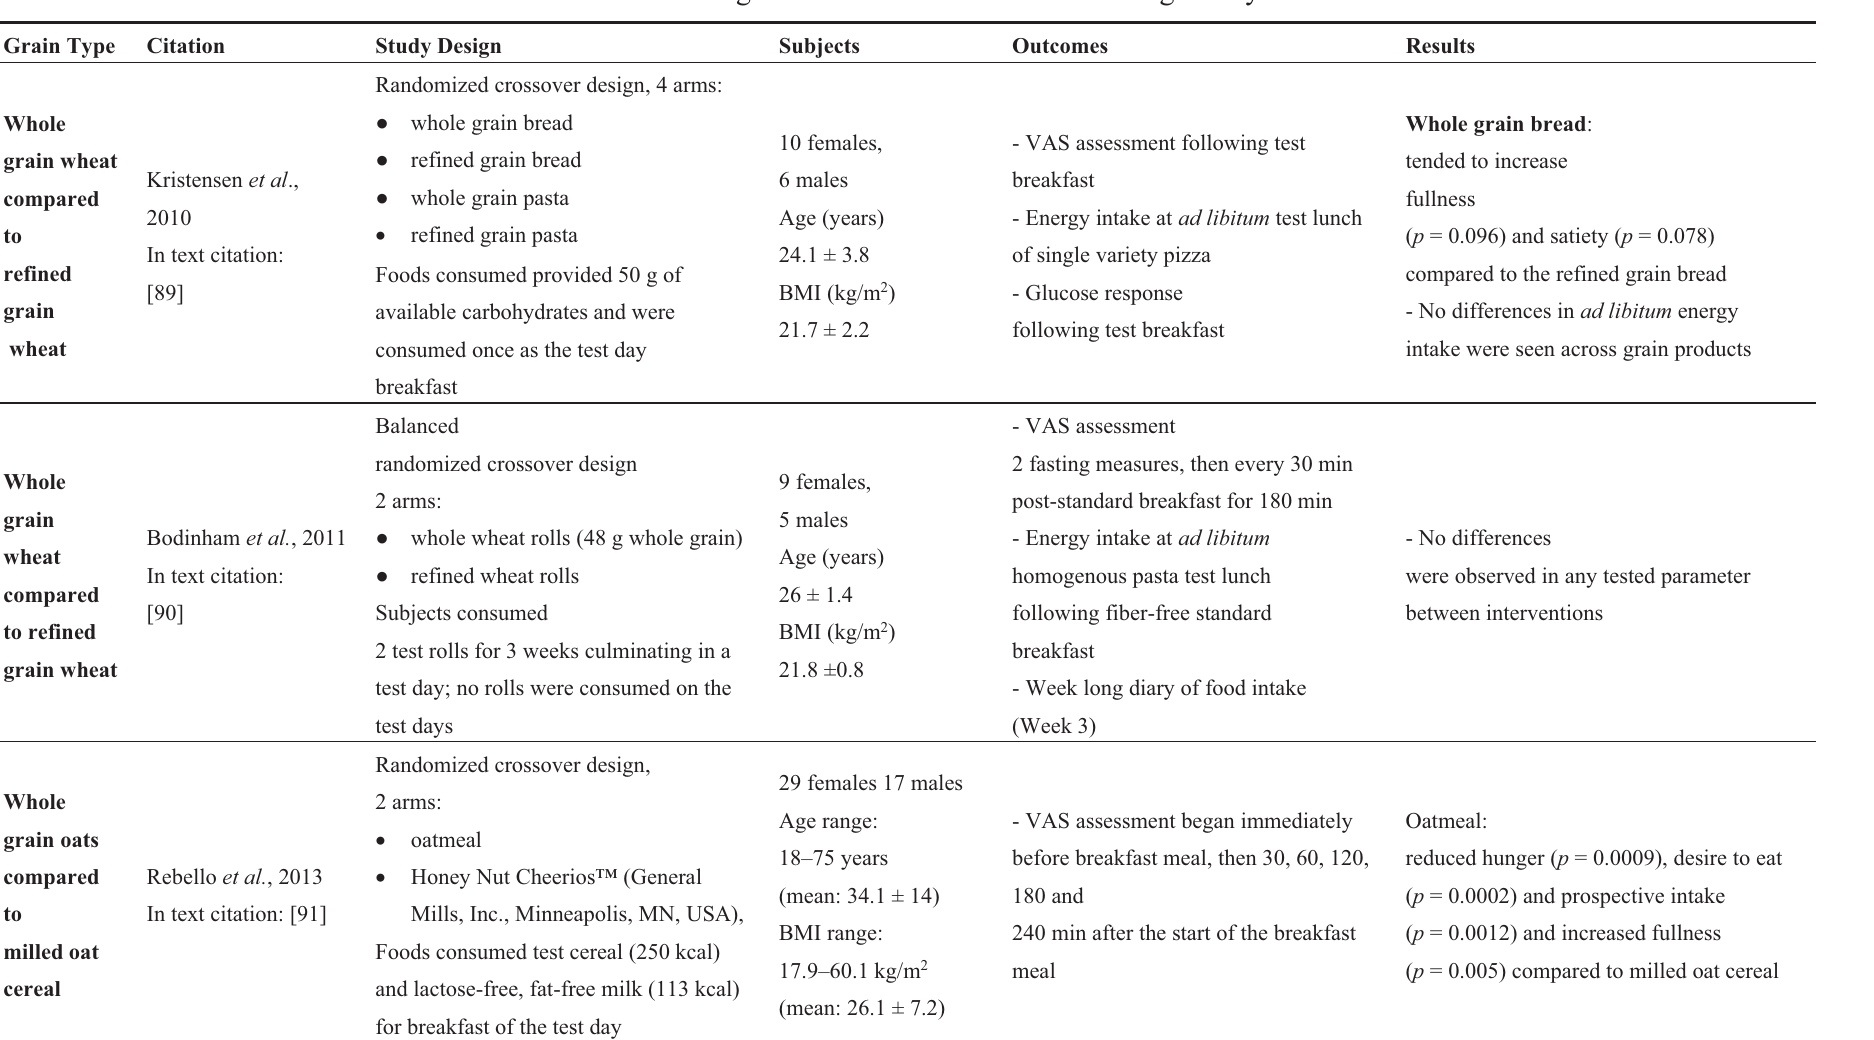
Table 2. Whole grain intervention studies examining